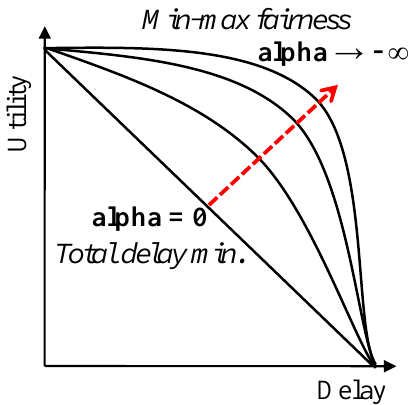
Figure 1. The proposed utility functions with varying α